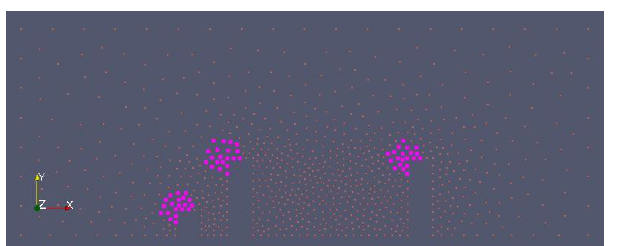
Fig. 12 Number of observations nobs = 6.